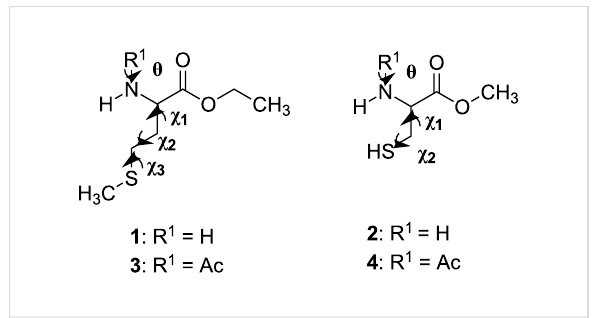
Figure 6: Definition of the selected dihedral angles for the studied